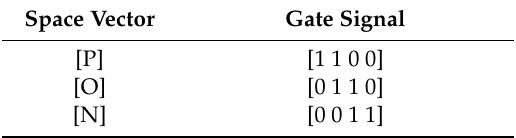
Table 2. The relationship between the output space vectors and their corresponding gate